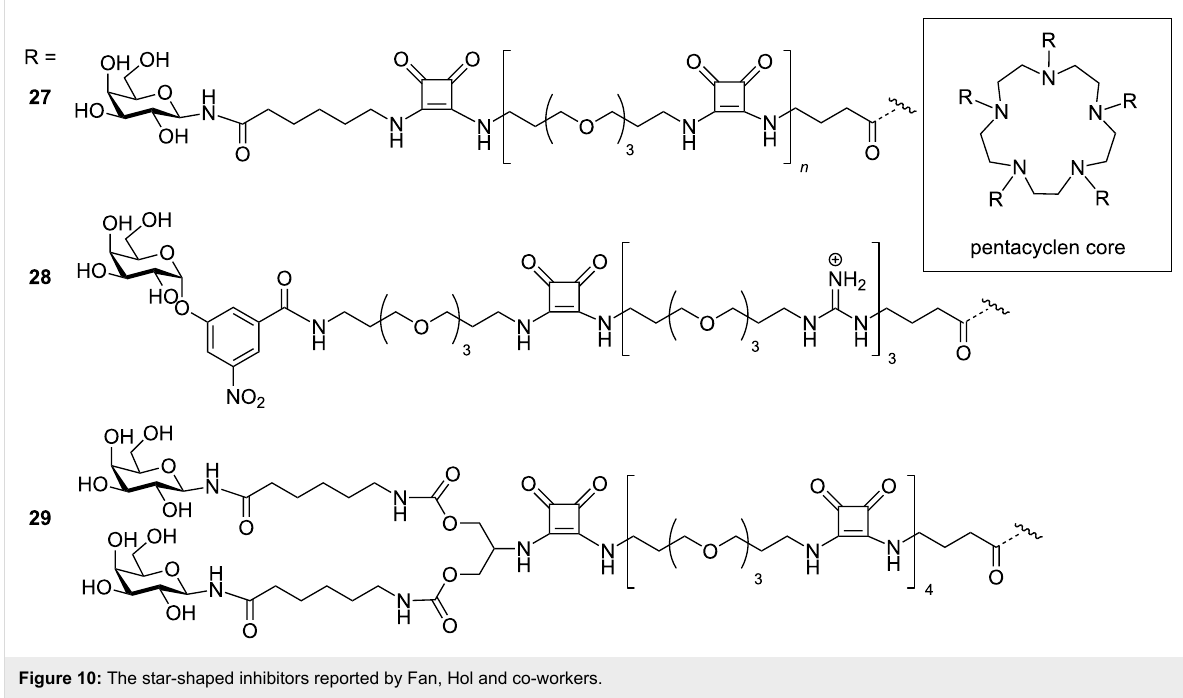
Figure 10: The star-shaped inhibitors reported by Fan, Hol and co-workers.